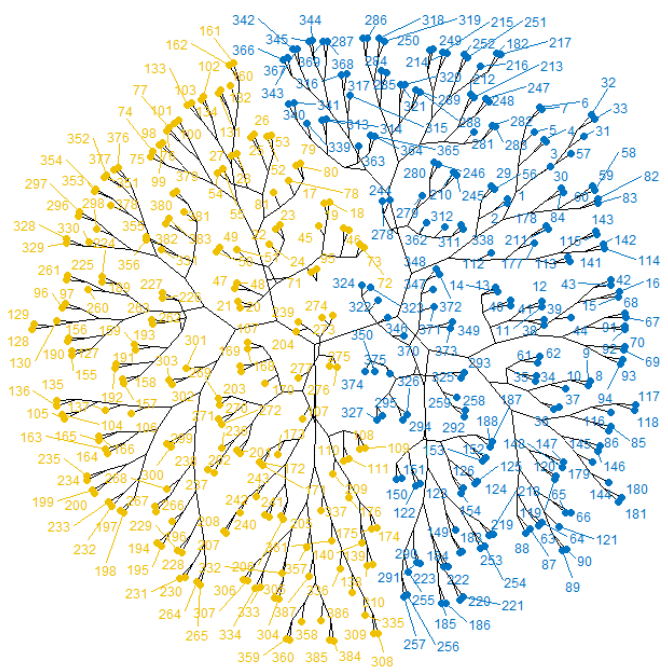
Figure 3. The dendrogram for classification of SITS. The elements in different clusters are in dif- ferent colors.